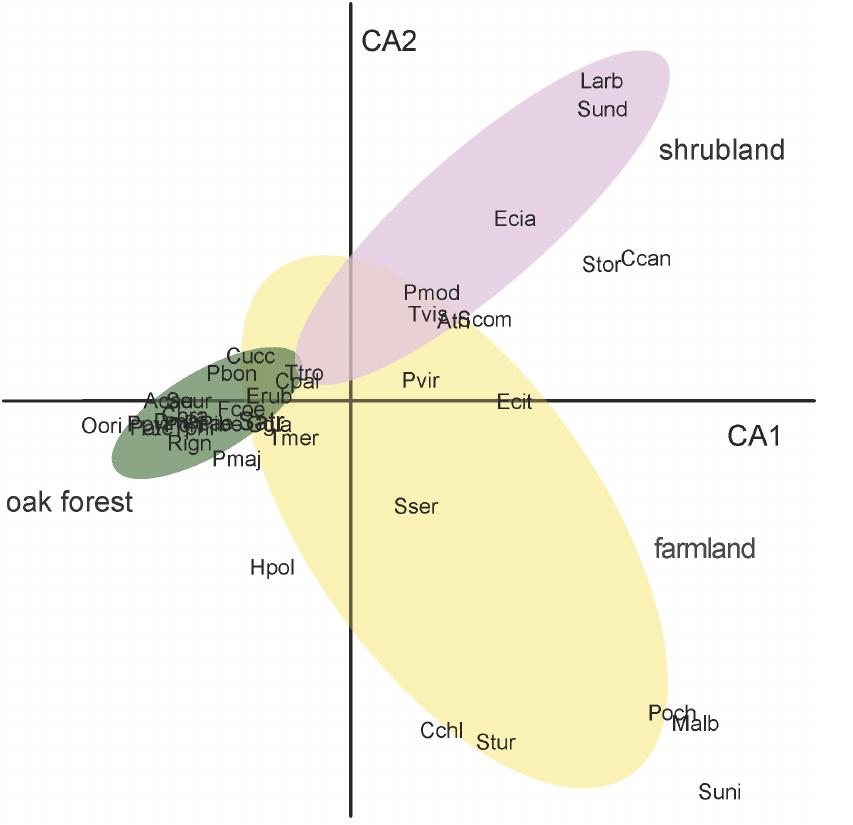
Figure 2. Plot of first two axes of the correspondence analysis of bird relative abundance versus point-count. The ellipses enclose the points of the same land-use (confidence region of 95%): farmland (yellow), shrubland (rose) and oak forest (green). Bird species are represented by their species code (see Table S1).